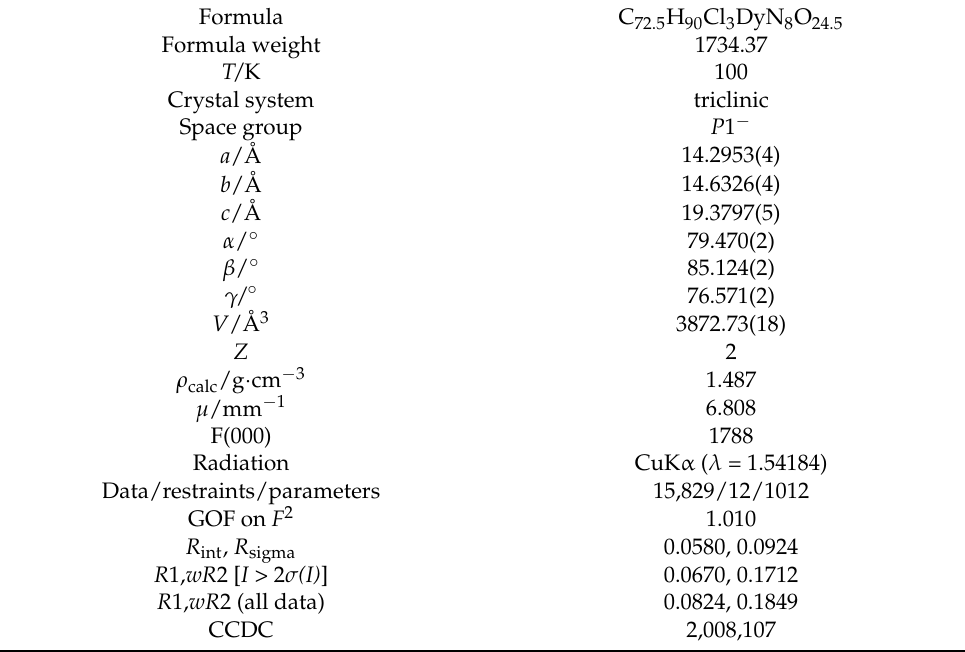
Table 1. Crystal data and refinement parameters for Complex 1 .